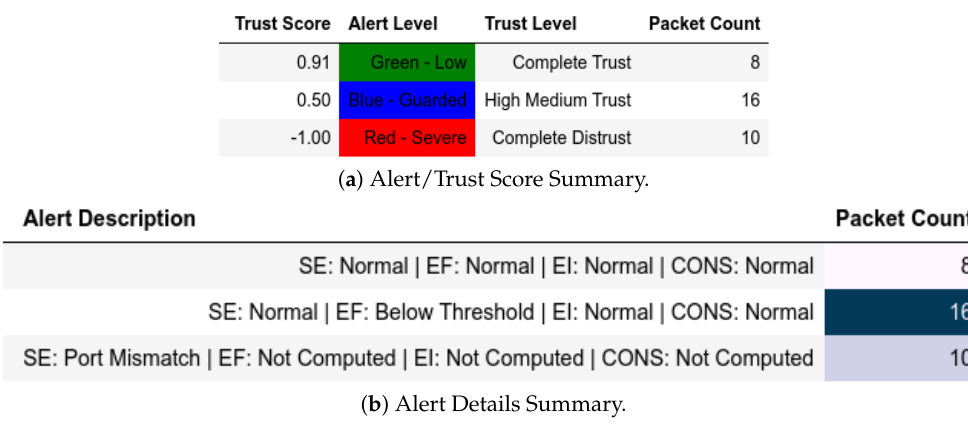
Figure 20. Client: EPM dataset internal test- H s in command-and-control capture with modified reference features.